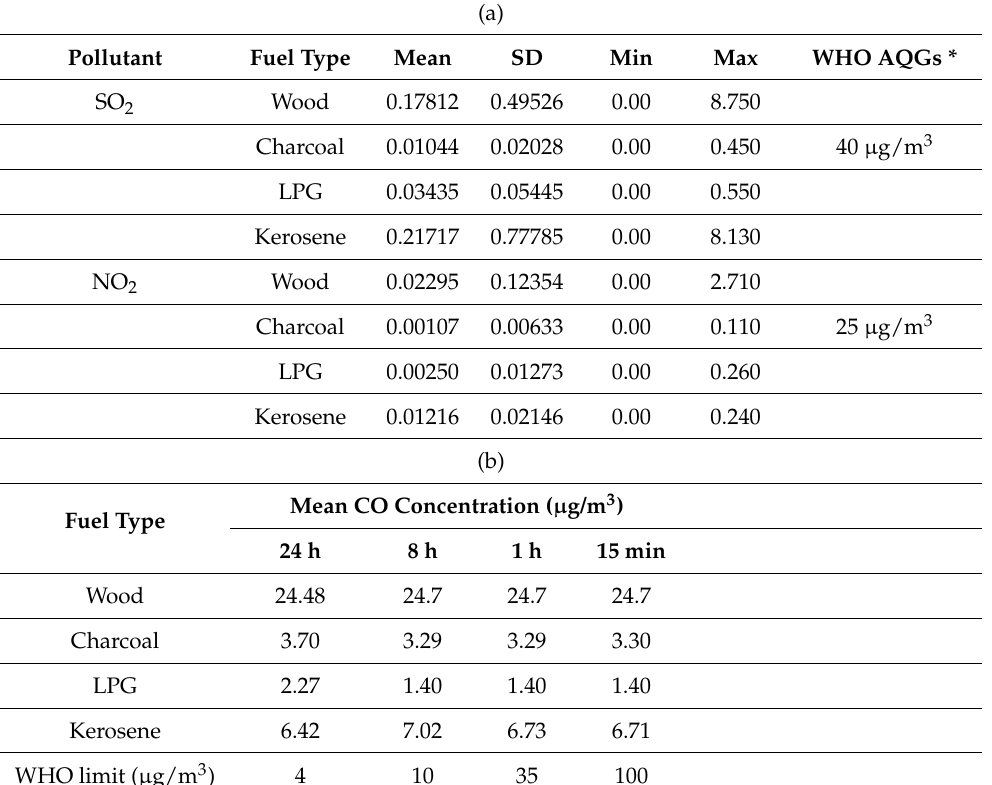
Table 3. (a): Mean 24 h concentrations ( µ g/m 3 ) of SO 2 , and NO 2 . (b): Mean CO concentrations against WHO